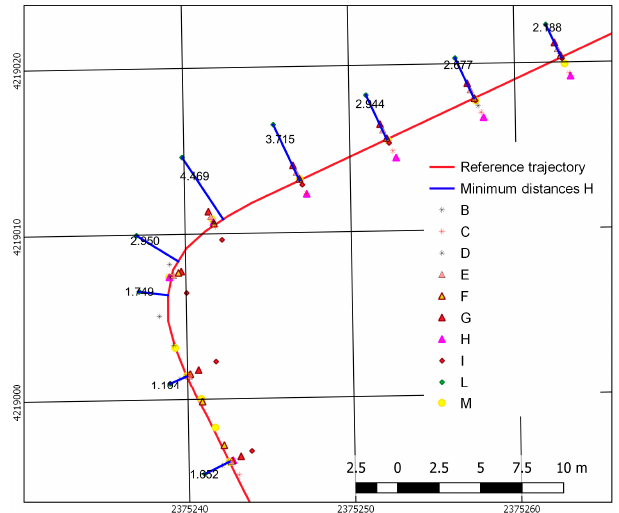
Figure 3. Outline of the method used for computing the minimum distance from the points determined by each tested GNSS receiver to the reference trajectory; test H minimum distances are given as an example in this figure.